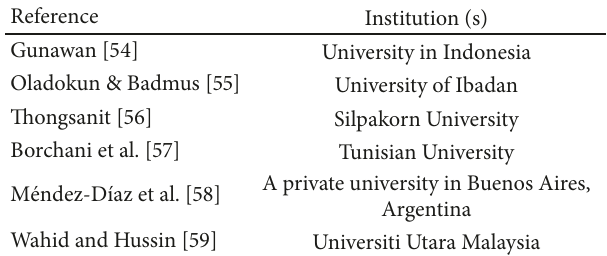
Table 5: Summary of real-world course timetabling datasets from different